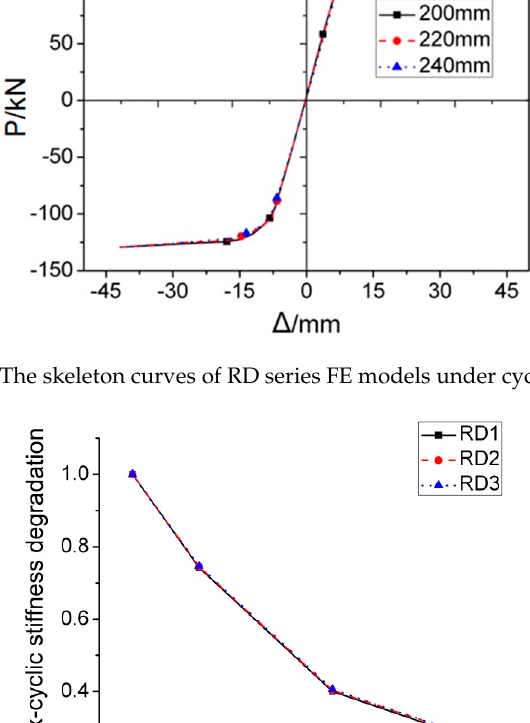
Figure 24. The Von Mises stress distributions along welding seam length (starting from edge to middle of welding seam) of RD series FE joint models.